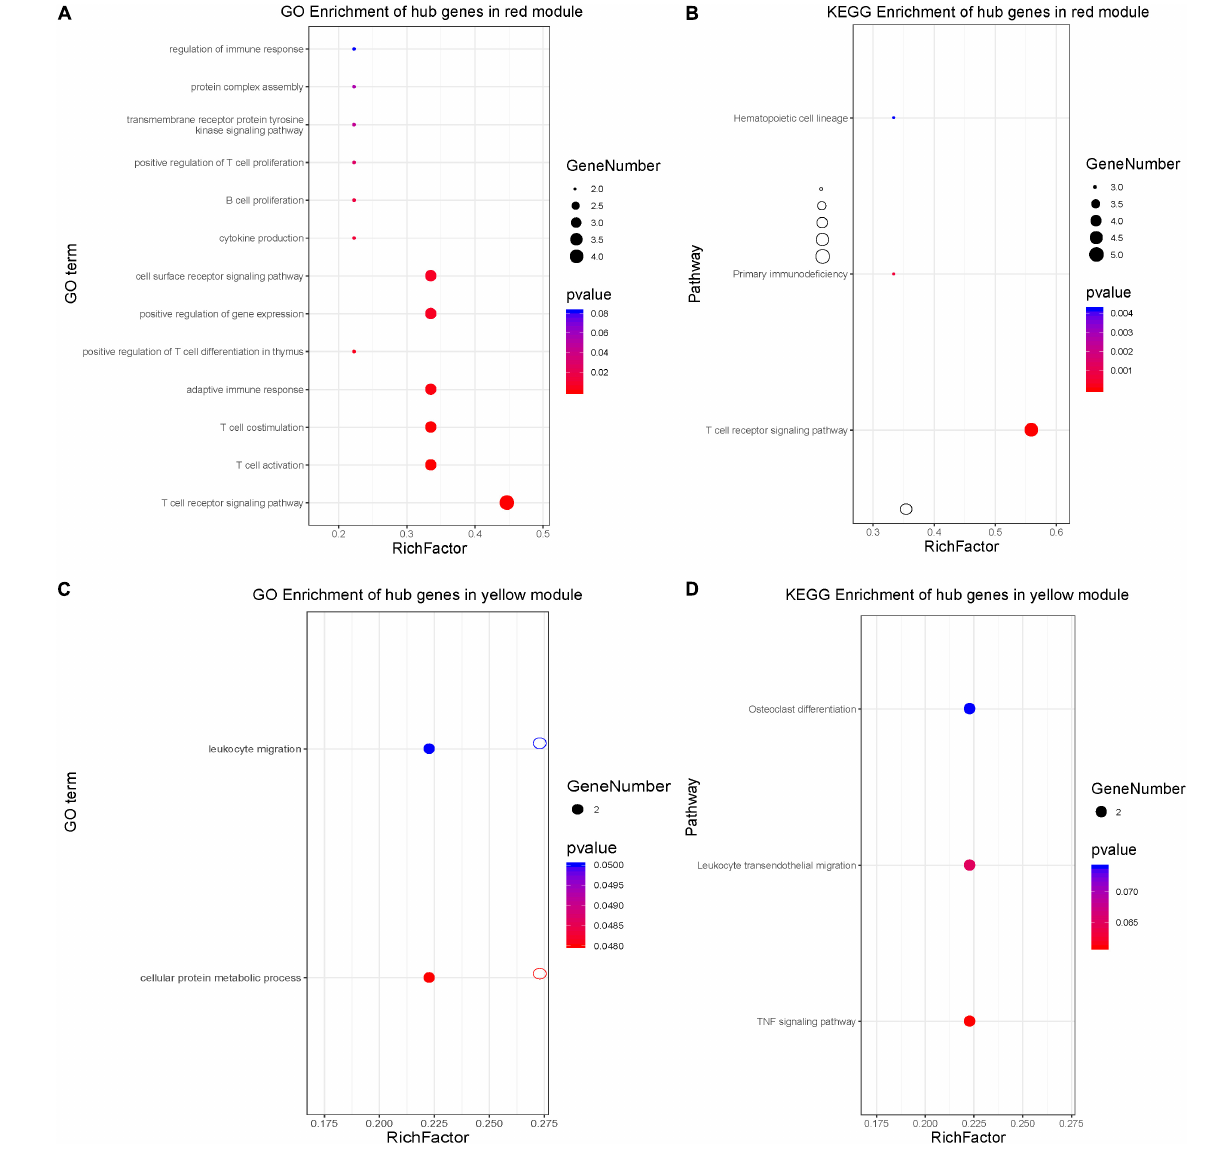
FIGURE 7 | Biological process and KEGG pathway enrichment analyses of hub genes. (A) Biological process analysis for the hub genes in the red module. (B) KEGG pathway enrichment for the hub genes in the red module. (C) Biological process enrichment for the hub genes in the yellow module. (D) KEGG pathway enrichment for the hub genes in the yellow